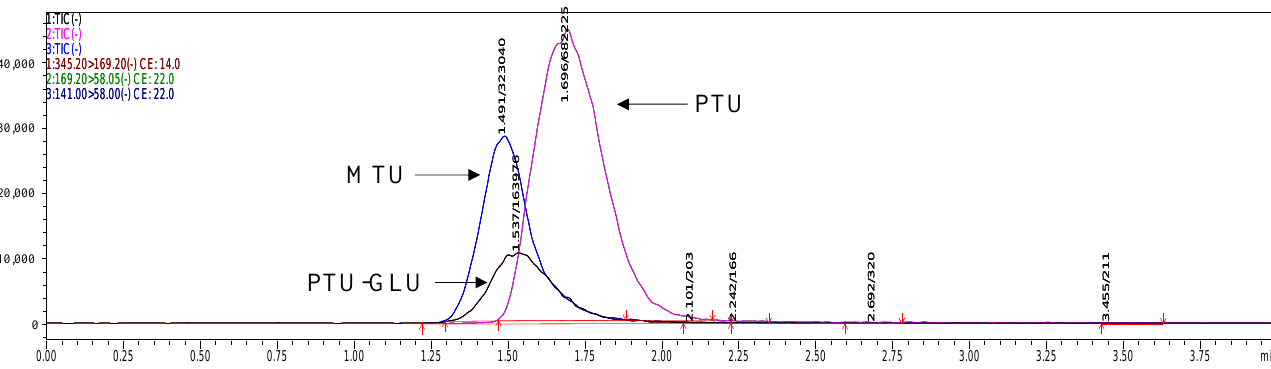
Figure 6. Representative HPLC profile of PTU and PTU-GLU. Propylthiouracil was incubated with the HLMs system at 37 °C for 60 min as described in Materials and Methods (Section 3.4).